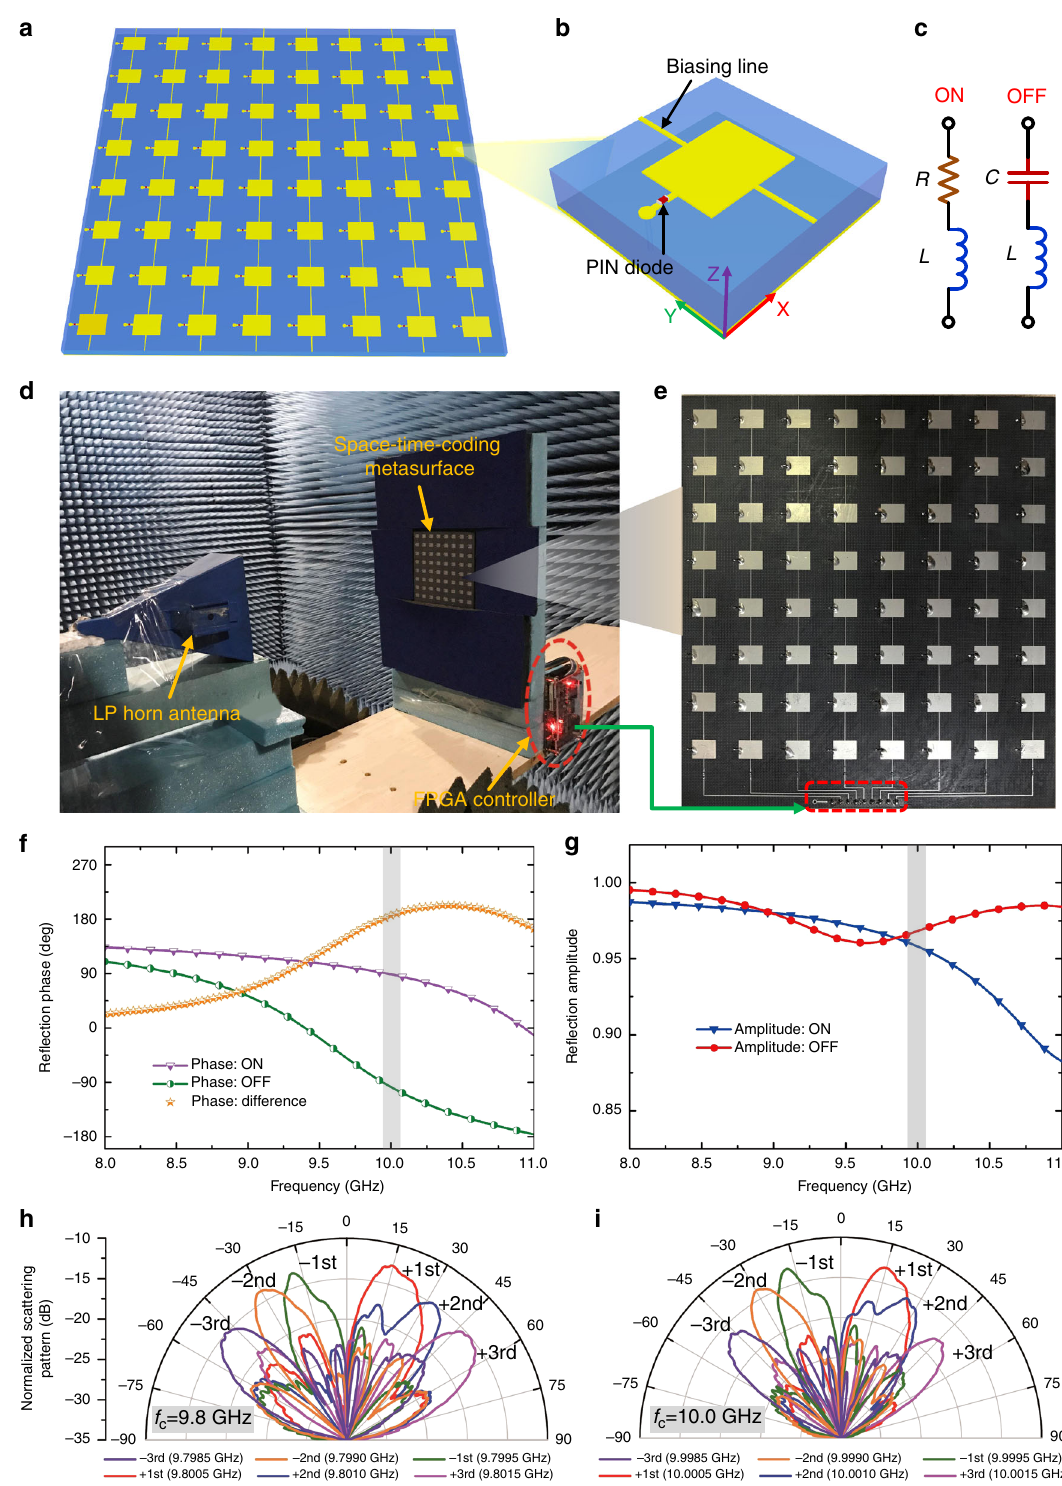
Fig. 6 Prototype design, modeling, and characterization. a Schematic of the realized space-time-coding metasurface prototype. b Geometry of the coding element with the biasing line. c Equivalent circuit models of the PIN diode biased at the “ ON ” and “ OFF ” states. d Measurement setup in an anechoic chamber. e Photo of the fabricated prototype. f , g Numerically computed re fl ection phase and amplitude of the coding element, respectively, for both diode states as a function of frequency. The grey-shaded areas indicate a neighborhood of the operational frequency (10 GHz). h , i Measured scattering patterns at different harmonic frequencies, for excitation frequencies of 9.8 and 10 GHz,